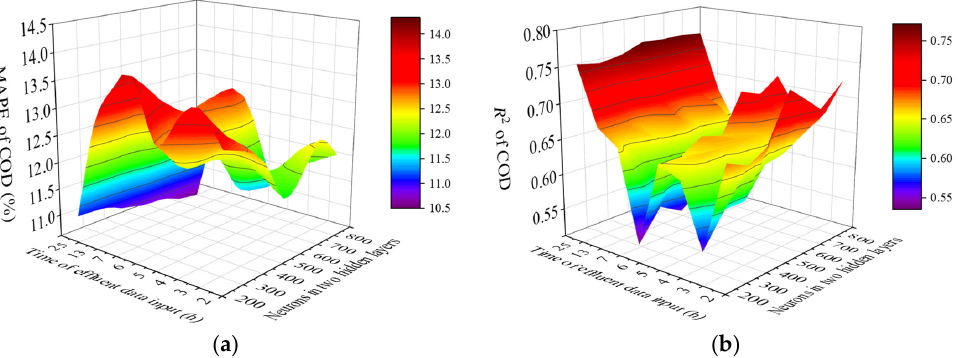
Figure 7. Change of IFFNN performance for COD with artificial neurons in the two hidden layers and time period of historical effluent data input: ( a ) MAPE and ( b ) R 2 of test datasets.